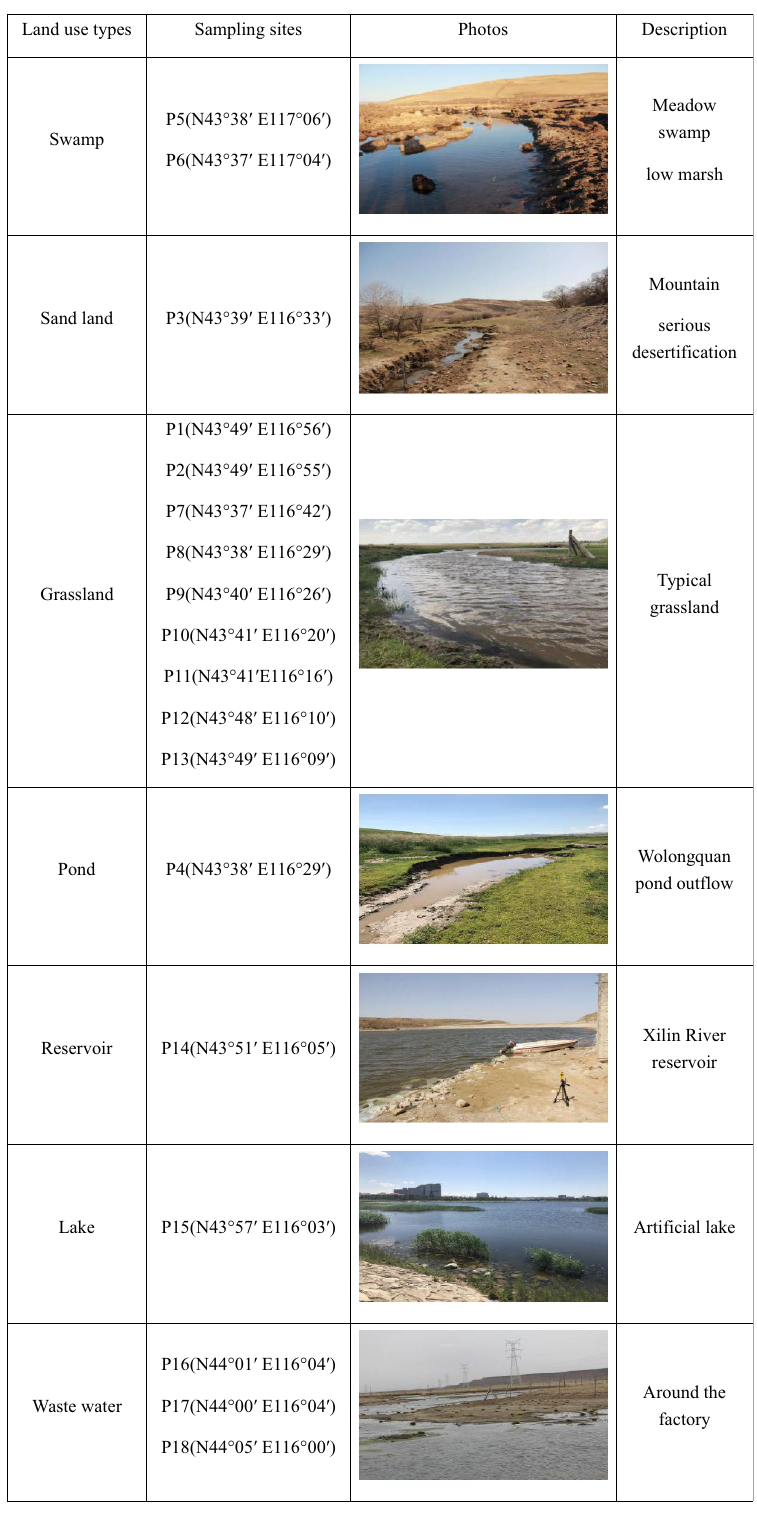
Table 1. Sampling sites classified by land use type. *These pictures were taken by